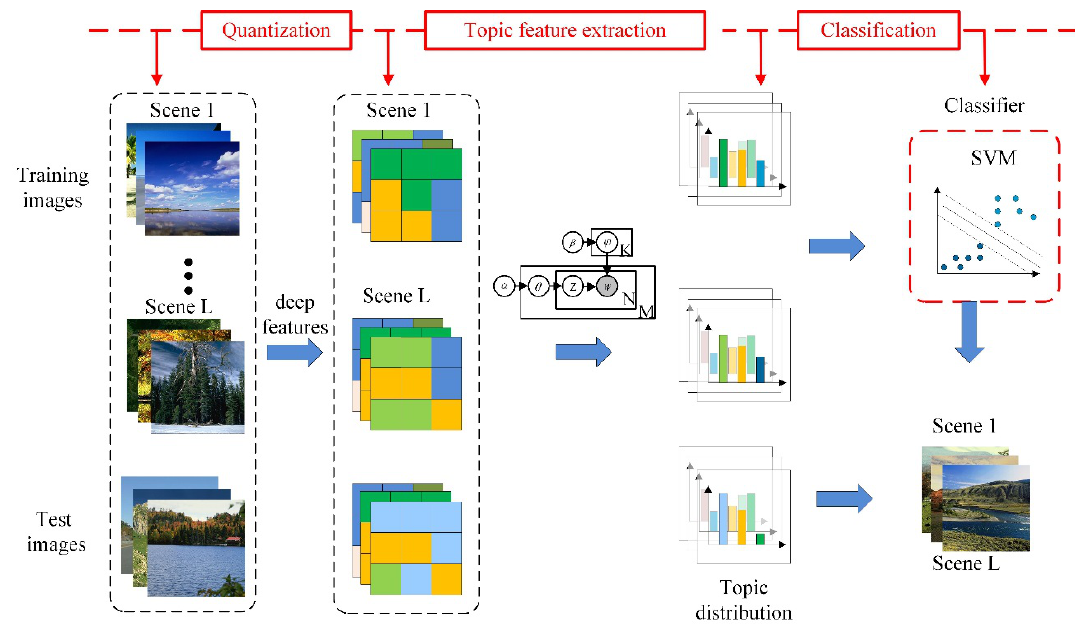
Figure 5. Overview of DF-LDA model in scene classification.